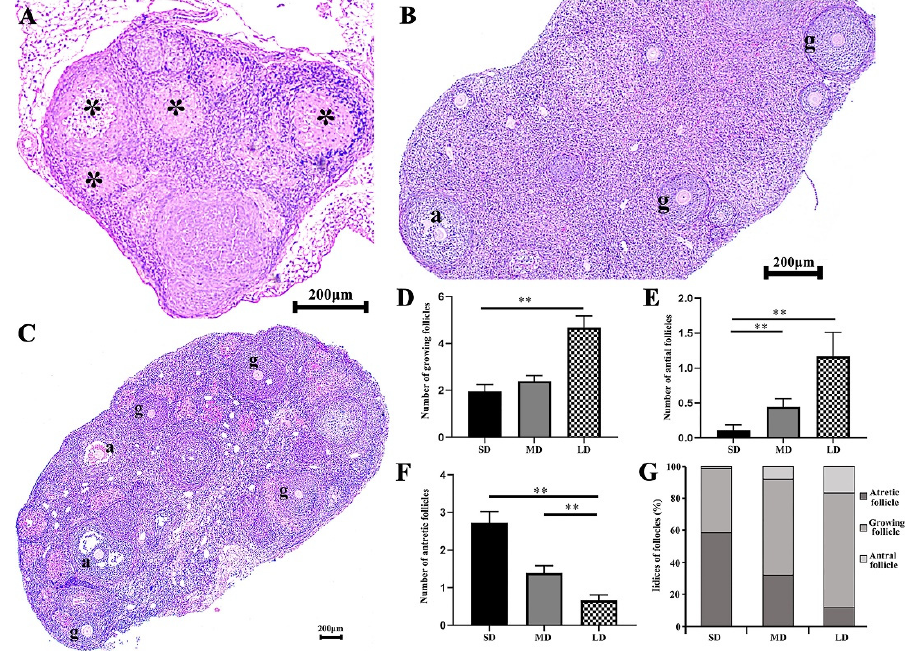
Figure 3. Differences in the number of follicles by the H&E staining of the ovaries of Phodopus sungorus under different photoperiods. ( A ) Ovarian section from the SD individuals. ( B ) Ovarian section from the MD individuals. ( C ) Ovarian section from the LD individuals. ( D ) Differences in the number of growing follicles across the different photoperiods. ( E ) Differences in the number of antral follicles across the different photoperiods. ( F ) Differences in the number of atretic follicles across the different photoperiods. ( G ) Indices of the growing follicles, antral and atretic follicles under the different photoperiods. g, growing follicle; a, antral follicle; *, atretic follicle. Values are means ± SEM. Bar = 200 μ m; n = 3. SD, short daylight; MD, moderate daylight; LD, long daylight. * p < 0.05, ** p < 0.01.